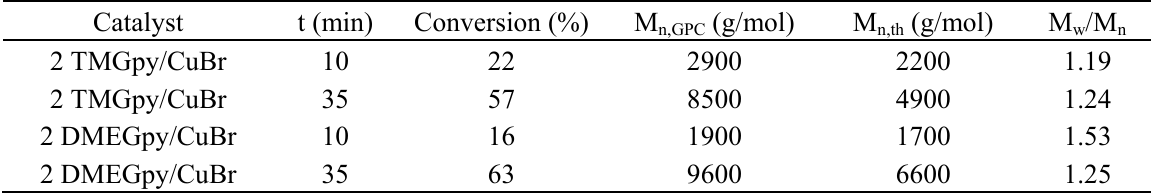
Table 4. Conversion, M 2 TMGpy/CuBr and 2 DMEGpy/CuBr and PEBr at 110 °C after 10 and 35 min.